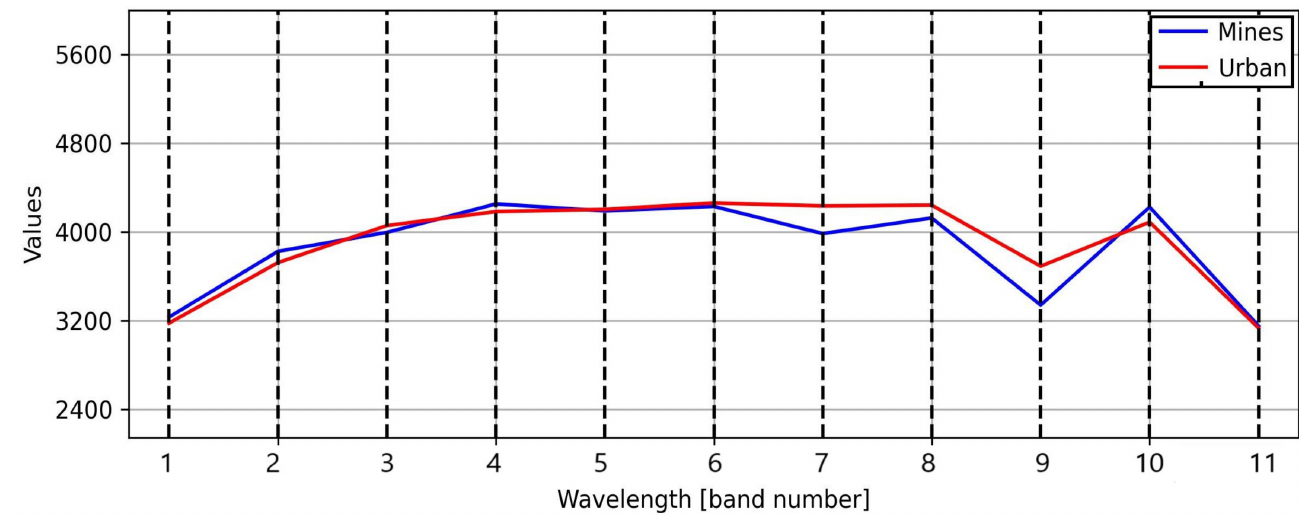
Figure 13. Spectral signature plot for the category of open-pit mines (blue line) and urban areas (red line) on Milos island as obtained by Sentinel-2 image in 2016. Each line reflects the dependence of the dimensionless surface reflectance value (vertical axis) on the corresponding band set wavelength (horizontal axis).